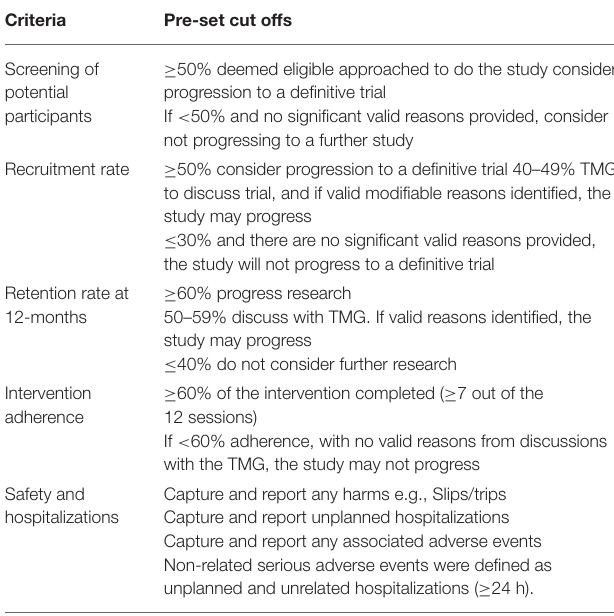
TABLE 1 | Feasibility outcomes and a priori progression